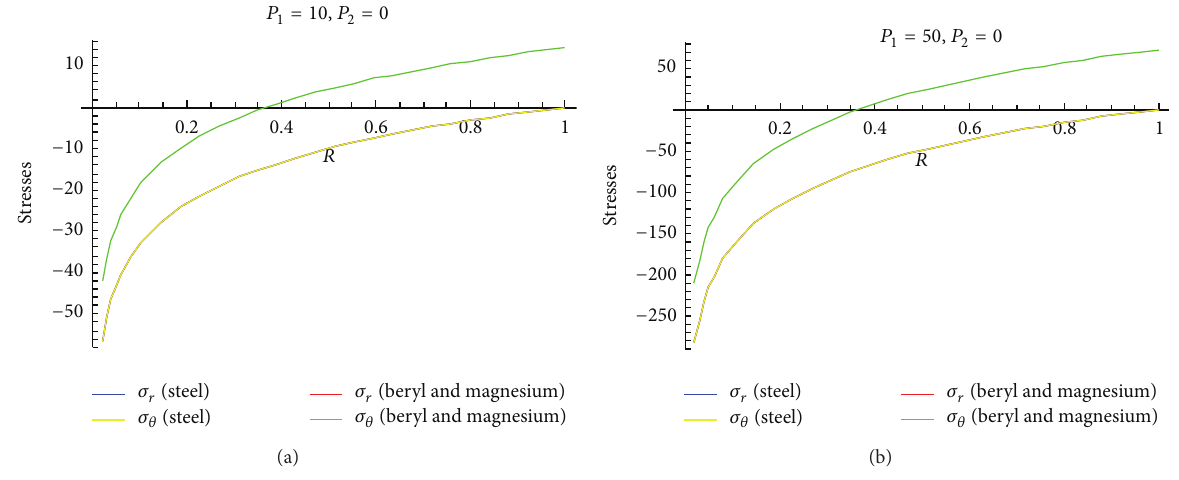
Figure 9: Fully plastic stresses when internal pressure 𝑃 1 = 10 and internal pressure 𝑃 1 = 50 (without external pressure). Table 1: Elastic constants 𝐶 𝑖𝑗 used (in units of 10 10 N/m 2 ).